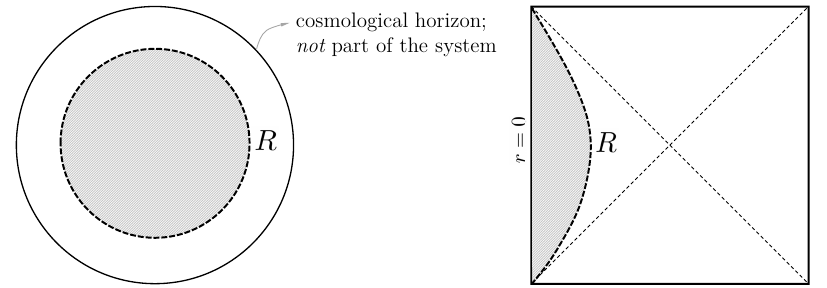
Figure 3. The stationary point “thermal de Sitter” as part of the static patch of de Sitter space, shaded on a space diagram (left) and on the Penrose diagram for the corresponding Lorentzian solution (right). The cosmological horizon lies outside the